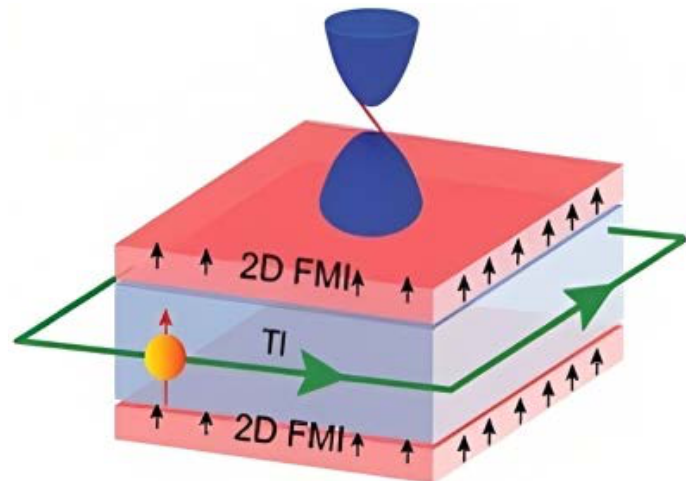
Figure 2. Upper hemisphere schematic represents in 2D TIs as conduction band (CB) and lower hemisphere represents the valence band (VB). The red line stands for surface states of 2D TIs which makes combination to separate CB and VB at a unique point called Dirac cone. spin magnetization in 2D TIs and upside black arrow in 2D TIs top surface and 2D TIs bottom surface represent to domain wall. © 2022 The Authors. Advanced Materials published by Wiley-VCH GmbH [51].